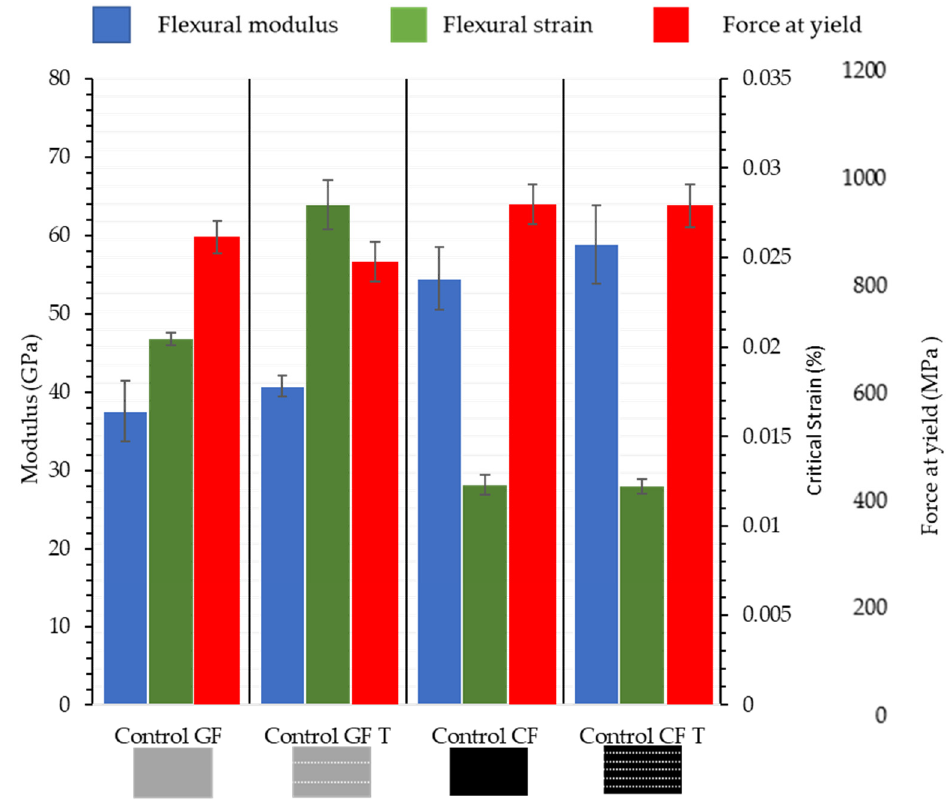
Figure 4. Yield strength of control samples of control Glass Fibre (GF) and Glass Fibre Toughened (GFT) and control Carbon Fibre (CF) and Control Carbon Toughened (CFT) fibre after three-point bending. Showing a strain increase with veil toughening for glass fibre. T denotes the interlayer veil toughening, where every layer of the controls used veil toughening.